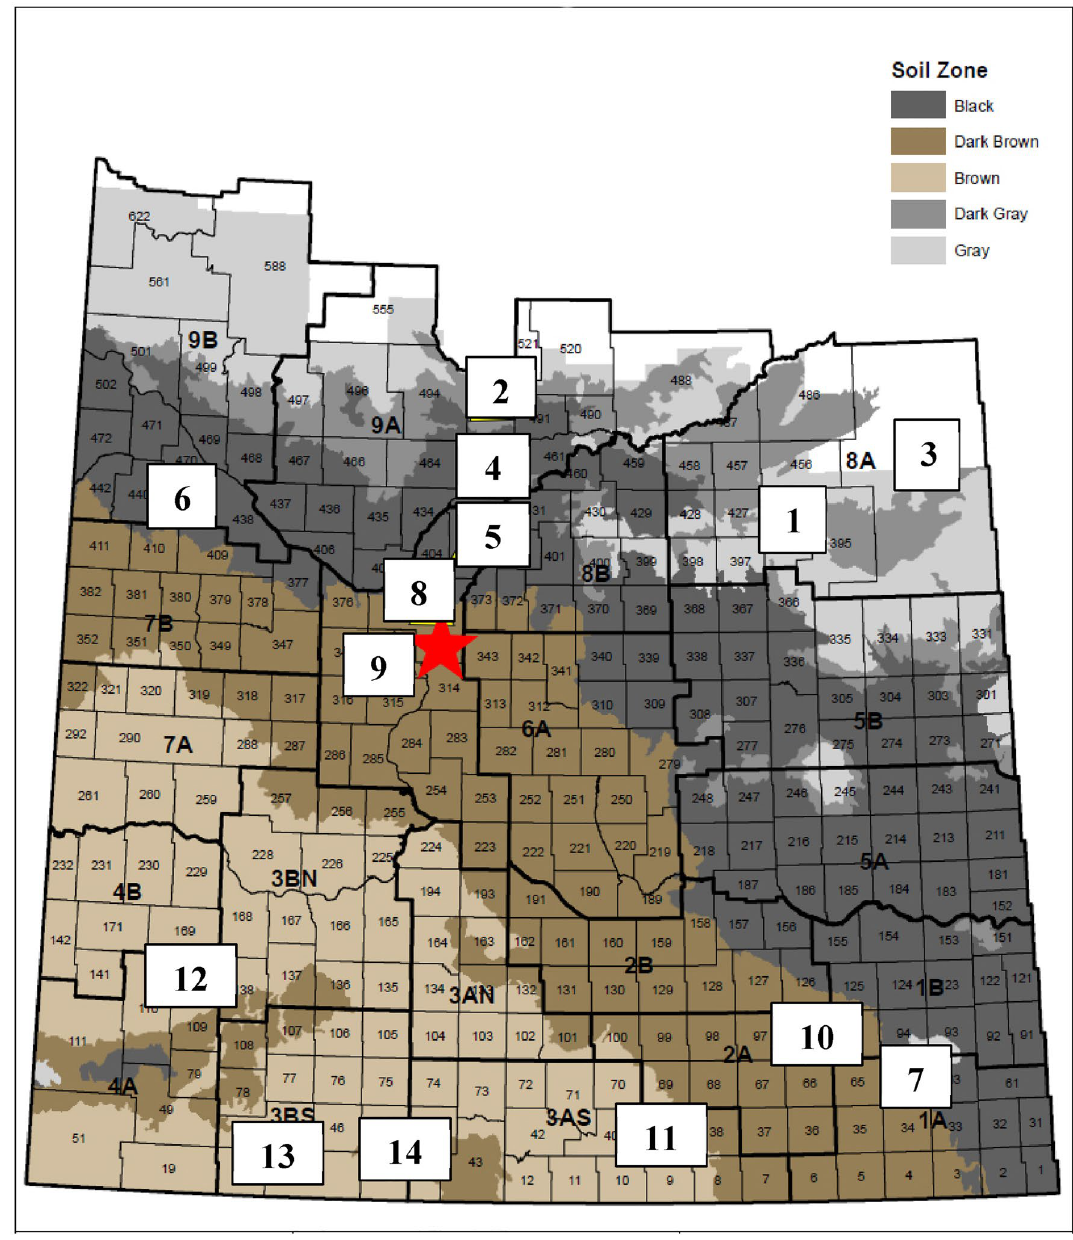
Figure 9. Locations of 14 long-term grazing sites for alfalfa plant selection during this study. (Sites names 1–14 are: Crooked River, Shellbrook, and Erwood; MacDowall, Duck Lake, Rockhaven and Arcola; Dalmeny, Pike Lake, and Fillmore; Ceylon, Gull Lake, Moose Jaw, and Val Marie). Map was adapted from Canadian Soil Information Service (https:// sis. agr. gc. ca/ cansis/ index. Phenotypic data analysis. For each phenotypic trait, a linear mixed model was used to perform analy- sis of variance (ANOVA) using JMP (JMP 15.2.1. SAS Institute Inc., Cary, NC). Soil zone, year, population (soil zone) and genotype (population, soil zone), soil zone × year, were treated as fixed effects in the model. The block was treated as a random effect. For each of six agro-morphological and three nutritive values traits, if the ANOVA indicated a significant difference at p ≤ 0.05 level, means were separated using the studentized Tukey multi-treatment method. Degrees of freedom were calculated using Satterthwaite’s method. Genotype-environment associations (GEA) were determined using the redundancy analysis (RDA) proce- dure using the R package “ vegan 2.5-7 version” with the rda function 95,96 . The long-term (1986–2015) lowest and highest air temperatures and total precipitation (from May to September) for GEA analysis were obtained from Canada Weather Stats (available at https:// www. weath ersta ts. ca/) and Environment Canada (available at https:// clima te. weath er. gc. ca/). The soil pH, nitrogen (NO3-N), phosphorus (P), potassium (K), sulfur (SO4- S), and electrical conductivity (E.C.) from each long-term grazing site were also added into the GEA 40 . The